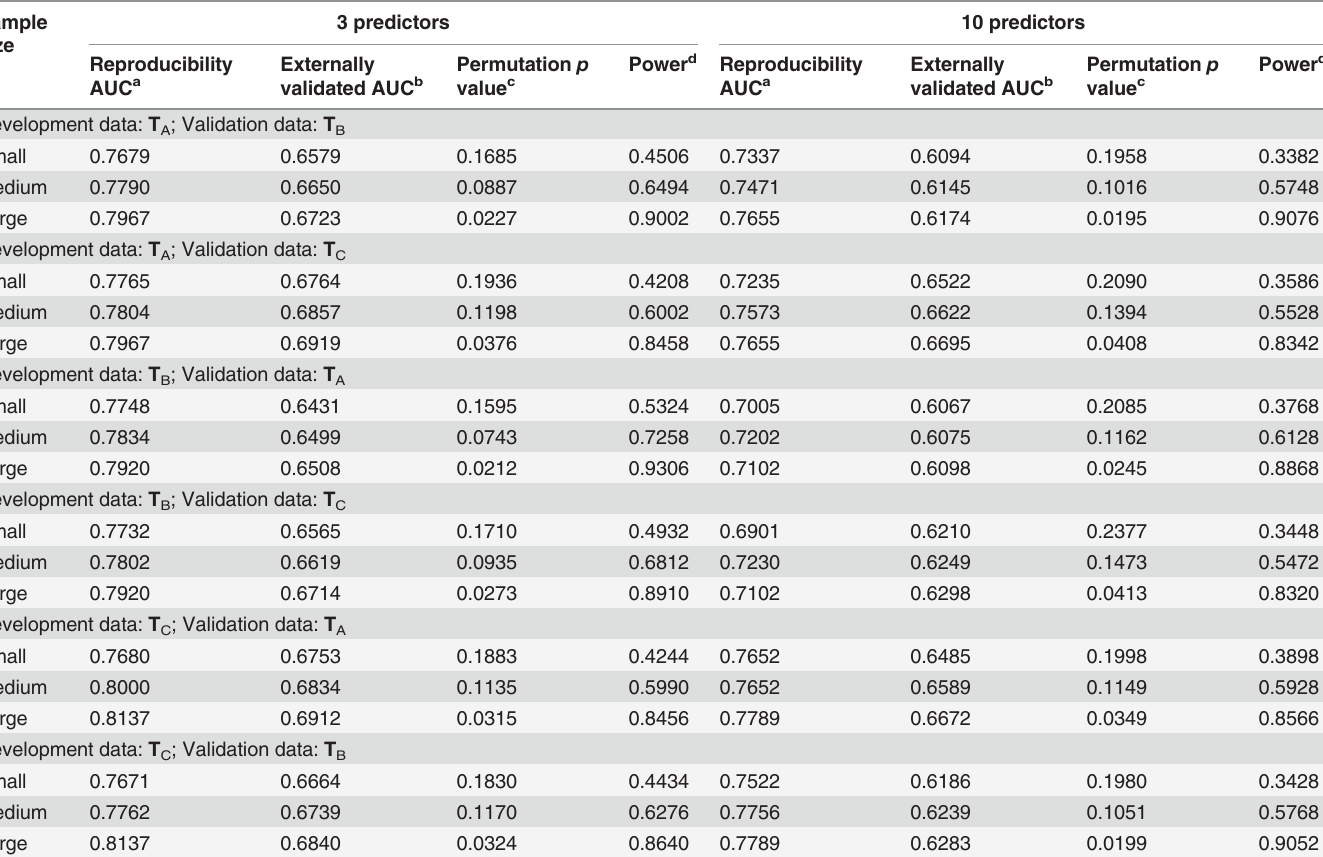
Table 2. Results of the permutation analysis for the heterogeneity